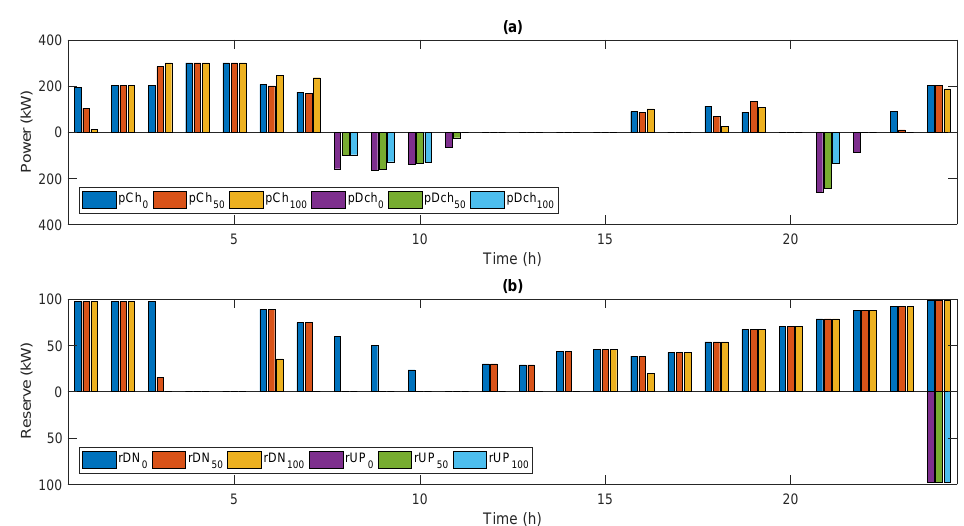
Figure 7. Power ( a ) and reserve ( b ) results for different values of the budgets of uncertainty ( Γ ).